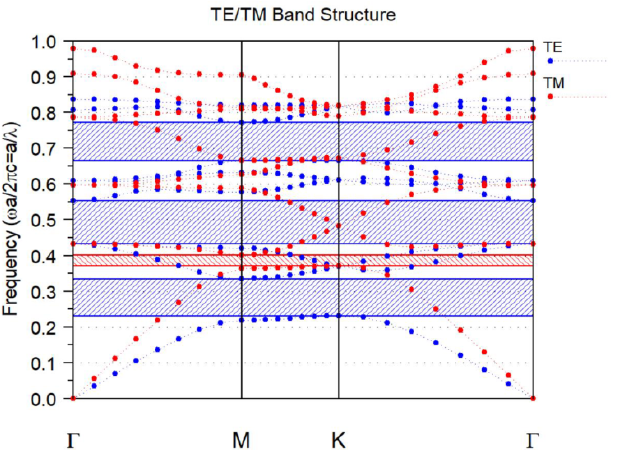
Figure 2. TE (blue) and TM (red) modes of energy band diagram for perfect photonic crystal.